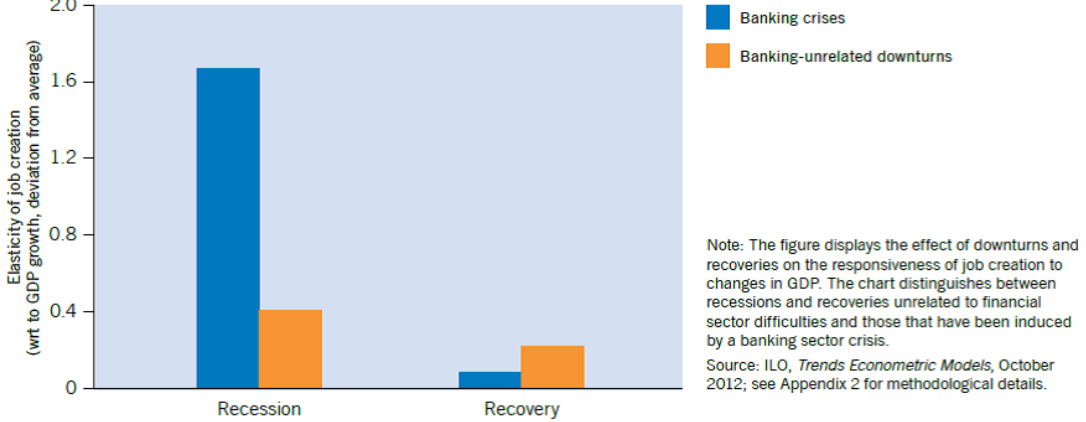
Figure 2: Banking crises and job creation